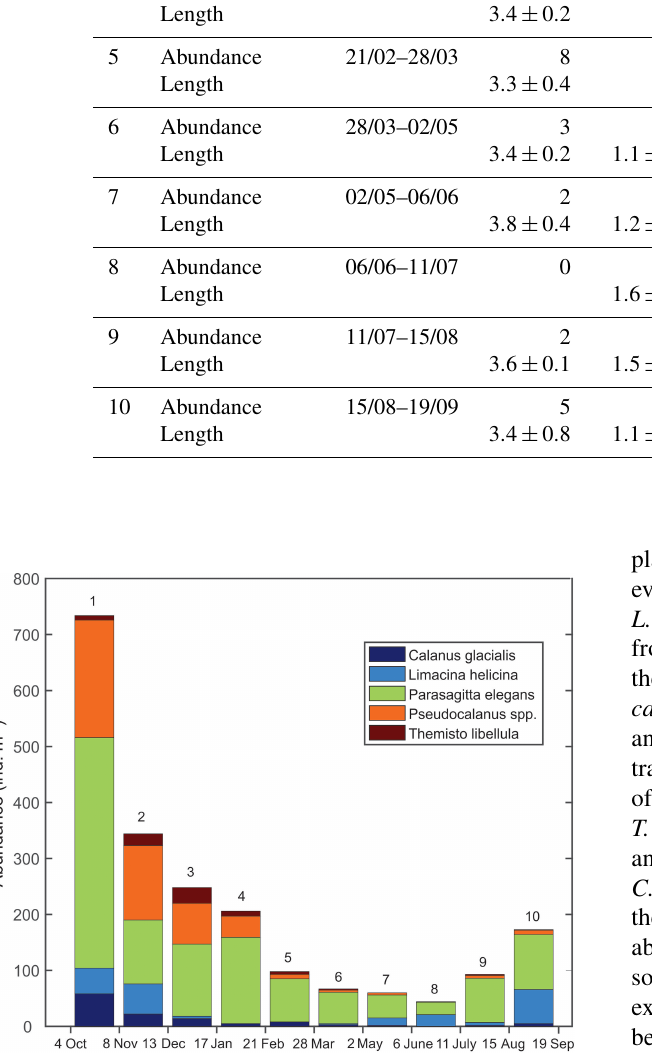
Figure 7. Abundance (ind . m − 3 ) of the dominant zooplankton ( > 500µm) in each bottle of the sediment trap at AN01 from Octo- ber 2016 to August